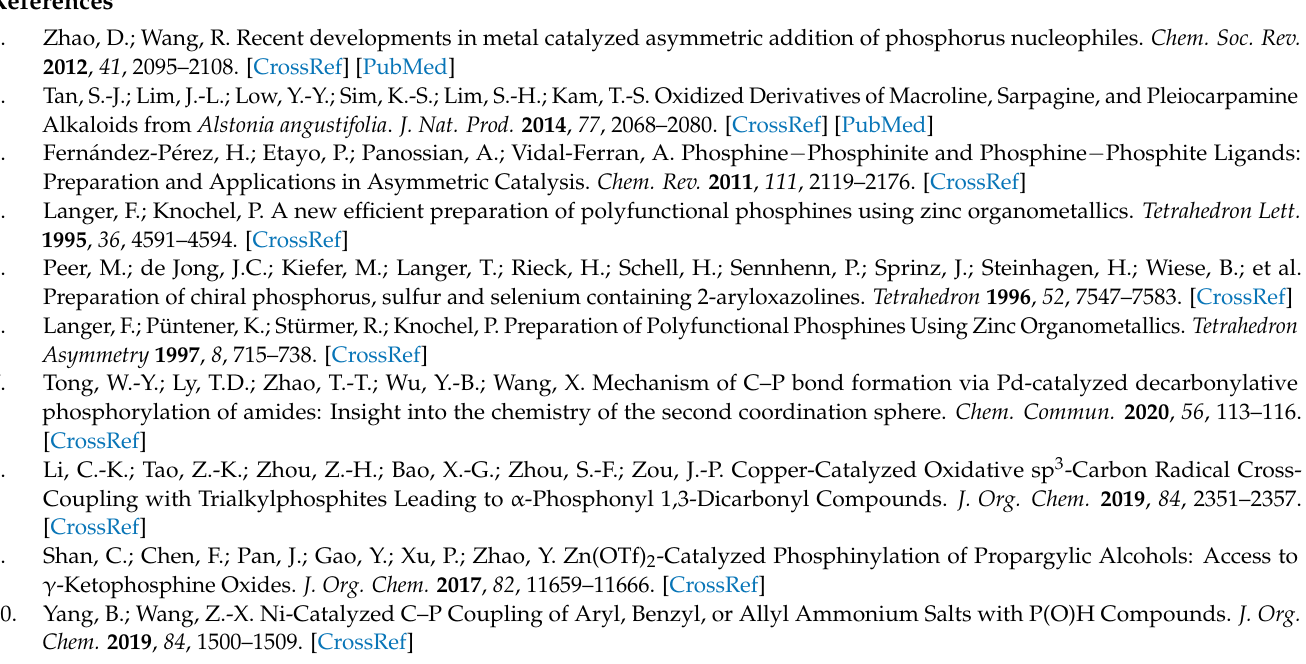
Figure S9: Optimized intermediates and transition states of pyridine phosphination with PPh 3 ; Figure S10: Optimized intermediates and transition states of 2-Ph-pyridine phosphination with PPh 3 to give the ortho-substituted product; Figure S11: Optimized intermediates and transition states of Phosphination of 2-Ph-pyridine with diarylfluoroalkylphosphines P1–P5; Figure S12: Optimized intermediates and transition states of The fluoroalkylation of pyridine in acidic solvent starting from a phosphonium salt; Table S2: Corrected free energies of all species; Table S3: Imaginary frequencies of all transition states; Table S4: Cartesian coordinates of all